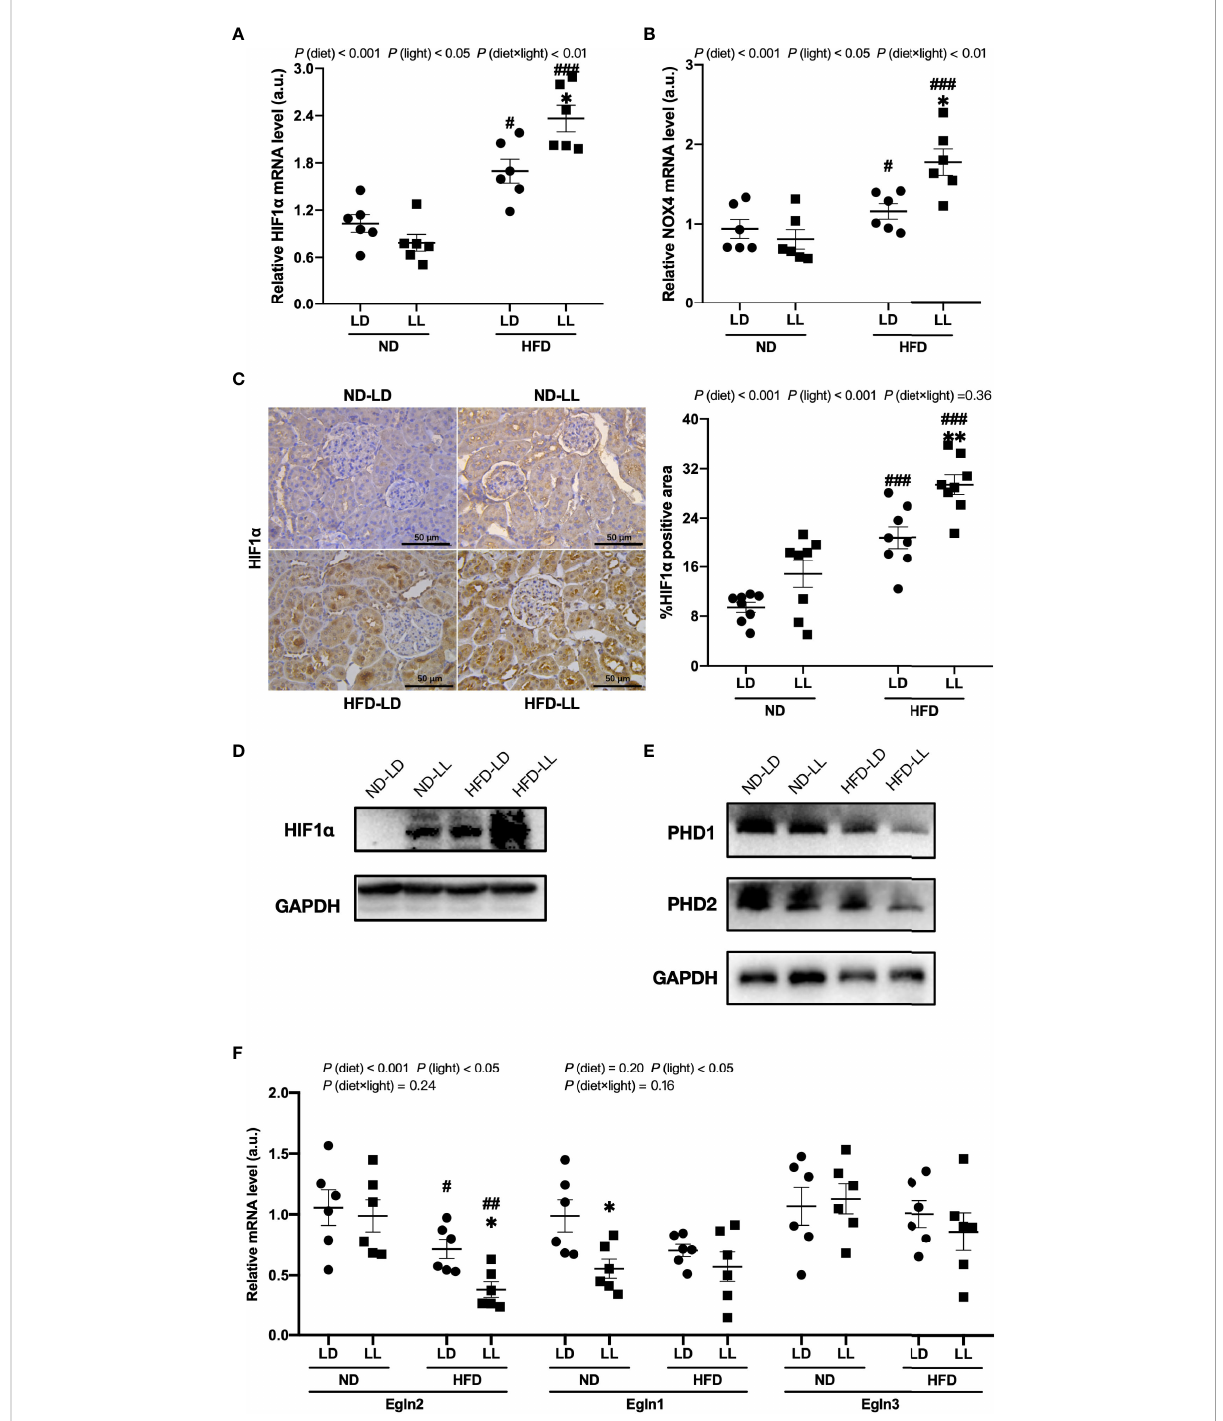
FIGURE 5 Effects of constant light exposure on renal expression of HIF1 a , NOX4 and PHD. (A, B) qPCR analysis of mRNA levels of HIF1 a and NOX4 in renal tissues of rats. (C) IHC staining of renal HIF1 a and semi-quanti fi cation analysis. (D) Western blot assays of HIF1 a expression in renal tissues. (E) Western blot assays of PHD1 and PHD2 expression in the renal tissues. (F) qPCR analysis of mRNA levels of PHD1 (Egln2) , PHD2 (Egln1) , and PHD3 (Egln3) in the kidney. Values represent mean ± SEM (n=6 for A, B and F , n=8 for C ). Differences were determined using a two-way ANOVA followed by a Bonferroni post hoc analysis. # p <0.05, ## p <0.01, ### p <0.001, vs. ND counterpart. * p <0.05, ** p <0.01, vs. LD counterpart. p (diet), main effect of diet; p (light), main effect of light; p (light × diet), interaction effect of light and